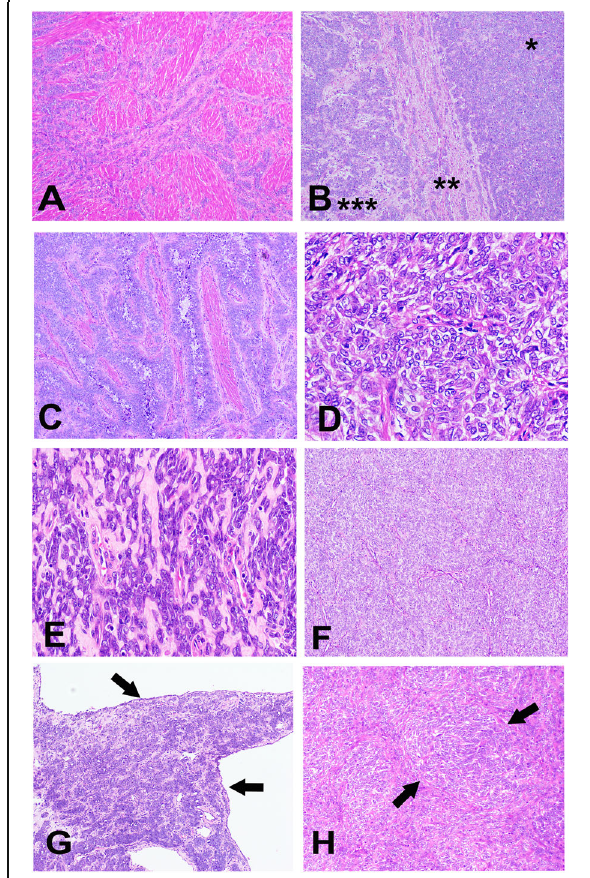
Fig. 1 Histological and cytological features of UTROSCT. a The tumor showed infiltrative growth into the myometrium (×20). b The tumor contained diffuse sheets (*), trabecular/cords (**), and nested growth patterns (***) (hematoxylin and eosin stain, ×100). c Focal anastomotic glandular growth pattern (×200). d The tumor was composed of short spindle and epithelioid cells with scant eosinophilic cytoplasm and round to ovoid bland vesicular nuclei with small or medium prominent nucleoli (×400). e The tumor contained thin-wall vessels in the stroma, and hyaline degenerated fibrous stroma was observed in the focal area (×400). f The recurrent tumor was composed of short spindle and epithelioid tumor cells arranged in inconspicuous nodules with few stroma (×200). g Cordlike pattern and the tumor with cystic changes (×100). h Focal whorls were present in the recurrent tumor